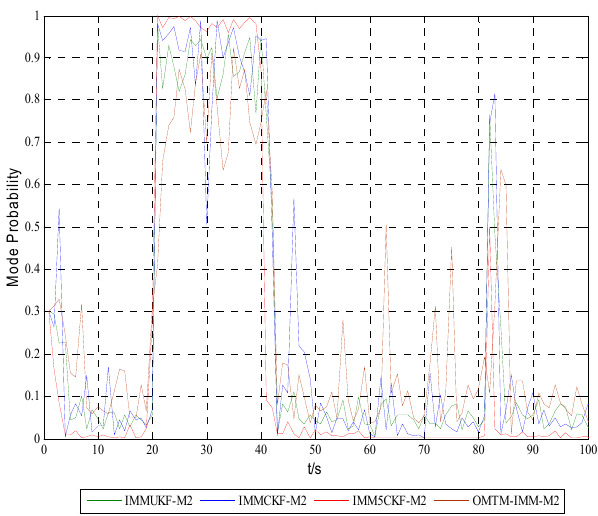
Figure 6. Model probabilities of model 2.